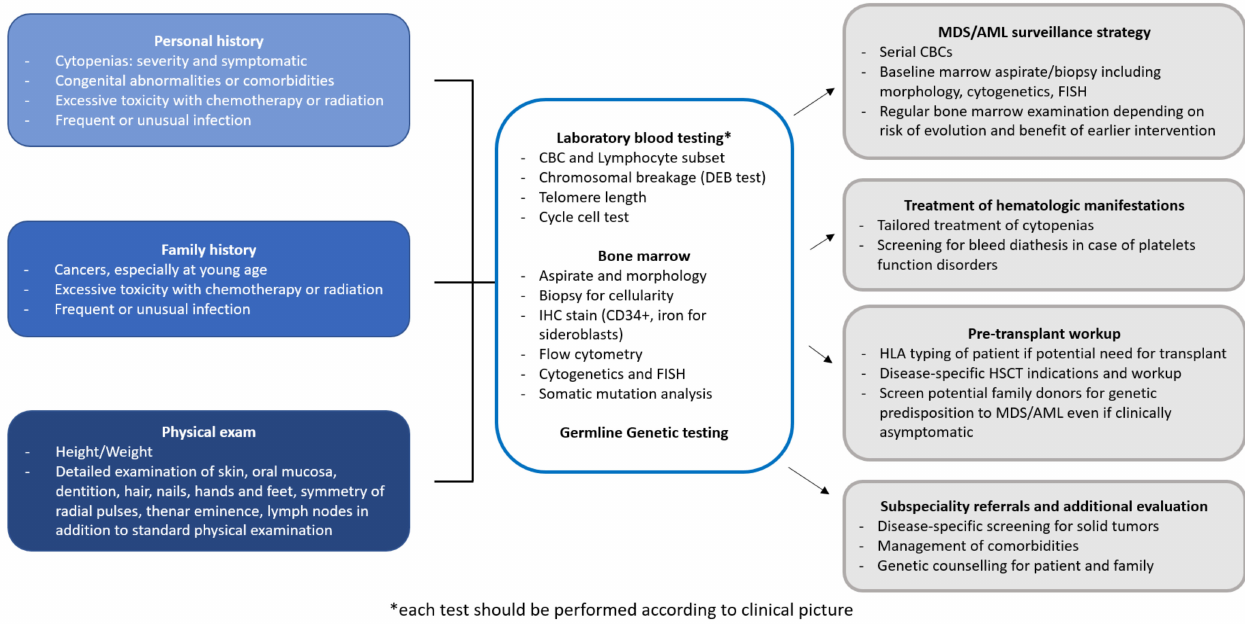
Figure 1. Diagnostic workup of a patient with suspected MDS predisposition syndrome. The diagnostic workup of a patient with MDS predisposition syndrome includes personal and family history, physical examination, and laboratory testing. Identification of a MDS predisposition syndrome has several implications for clinical management, concerning surveillance, treatment choice and pre-transplant workup in case of progression requiring therapy, and subspecialty referrals. AML, Acute myeloid leukemia; CBC, Complete blood count; FISH, Fluorescent in situ hybridization; ICH, Immunohistochemistry; HLA, Human leukocyte antigen; HSCT, Hematopoietic stem cell transplantation; MDS, Myelodysplastic